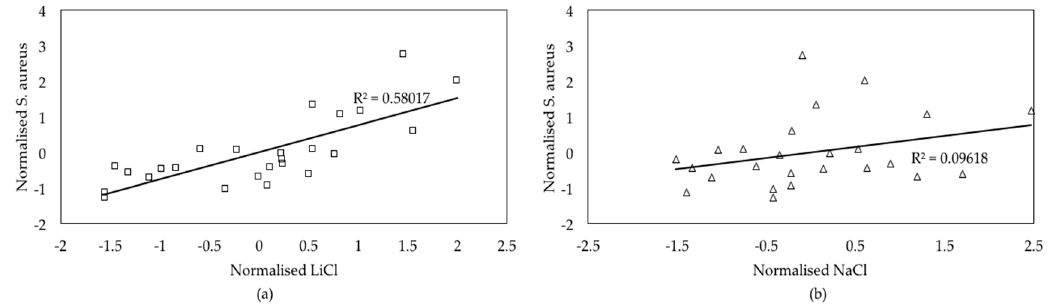
Figure 4. Linear regression of ( a ) LiCl on S. aureus and ( b ) NaCl on S. aureus.